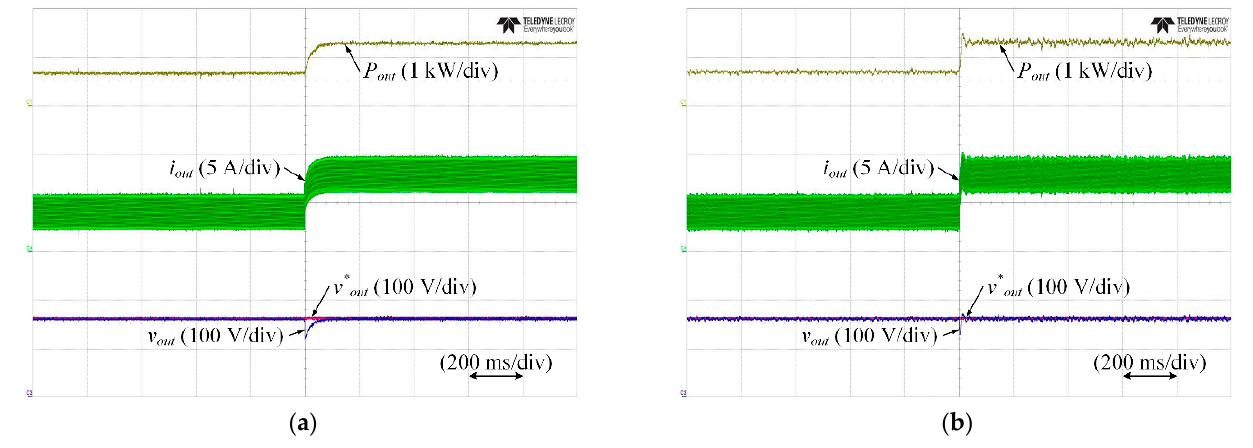
( b ) Figure 15. Experimental results of output voltage control of integrated OBC using ( a ) PI control and ( b ) the proposed MPC method. Figure 16 shows the experimental results of output voltage control of integrated OBC when the load impedance is abruptly changed (a) without a feedforward component of